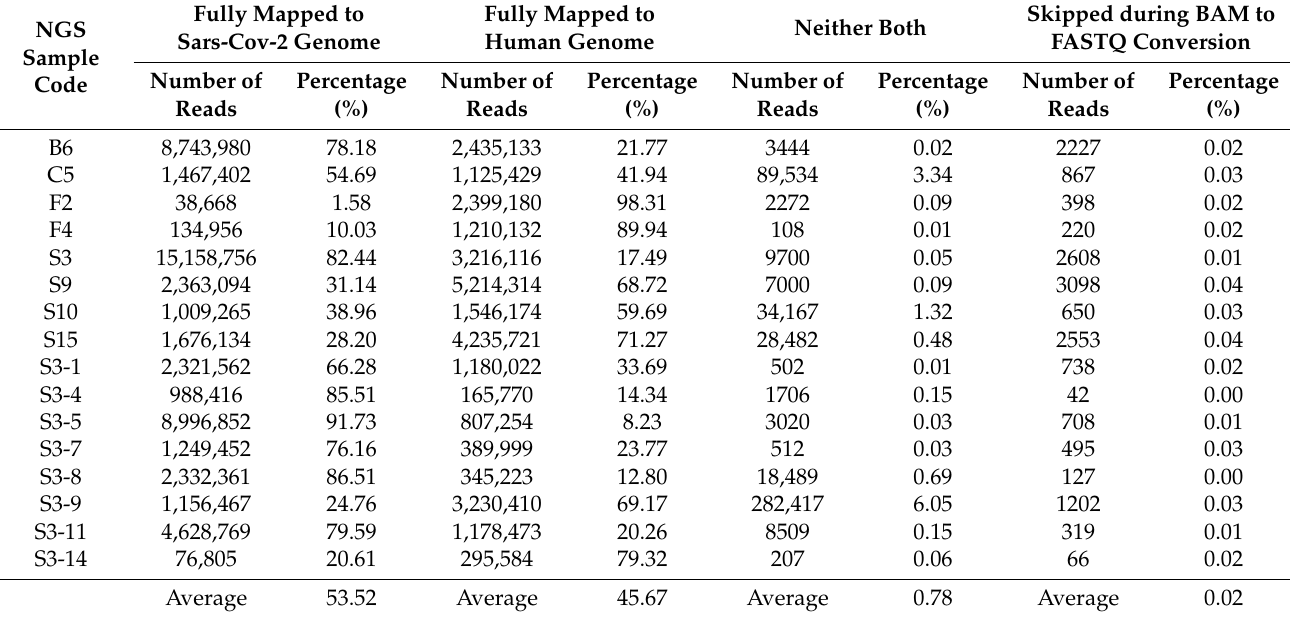
Table 5. Distribution of reads in each sample post-read mapping to the human genome (GRCh38) and SARS-CoV-2 genome (NC_045512.2).